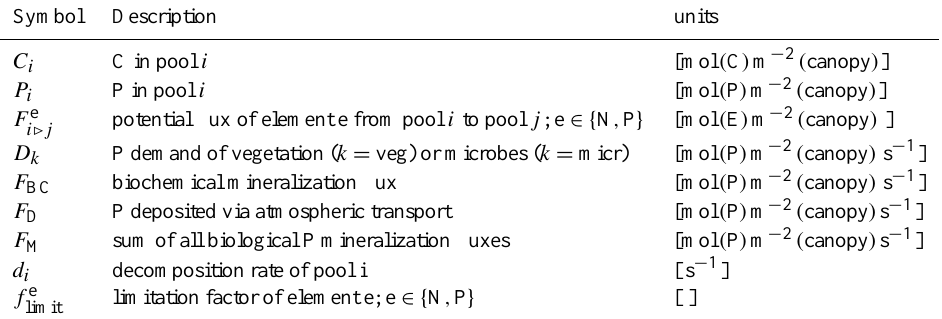
Table 1. Model variables (Fig. 1). For the C cycle, the indexes i and j are: A (atmosphere), a (active), w (wood), r (reserve), la (non-lignified litter), lw (litter wood), and s (slow). For the P cycle, the indexes i and j are: a (active), w (wood), m (mobile), la (non-lignified litter), lw (litter wood), s (slow), l (labile), and sr (sorbed). The index e stands for the element (N or